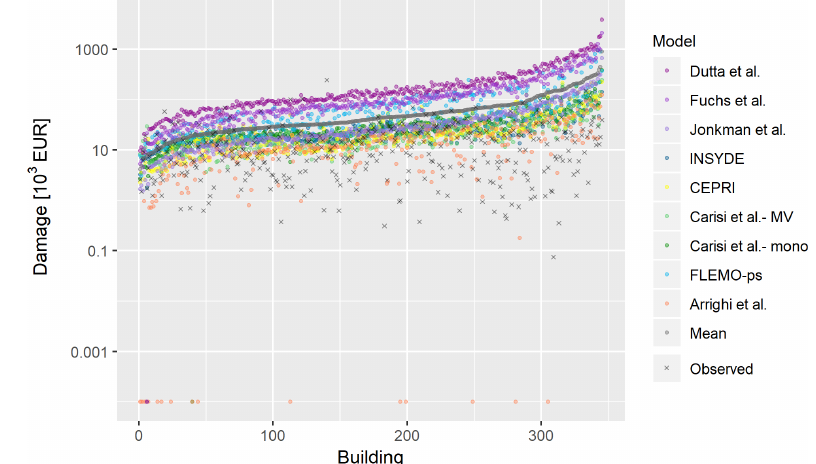
Figure 8. Observed damage vs. individual estimates of the monetary damage for the subset of buildings with claims. Data are ordered according to increasing value of mean estimate (in black).